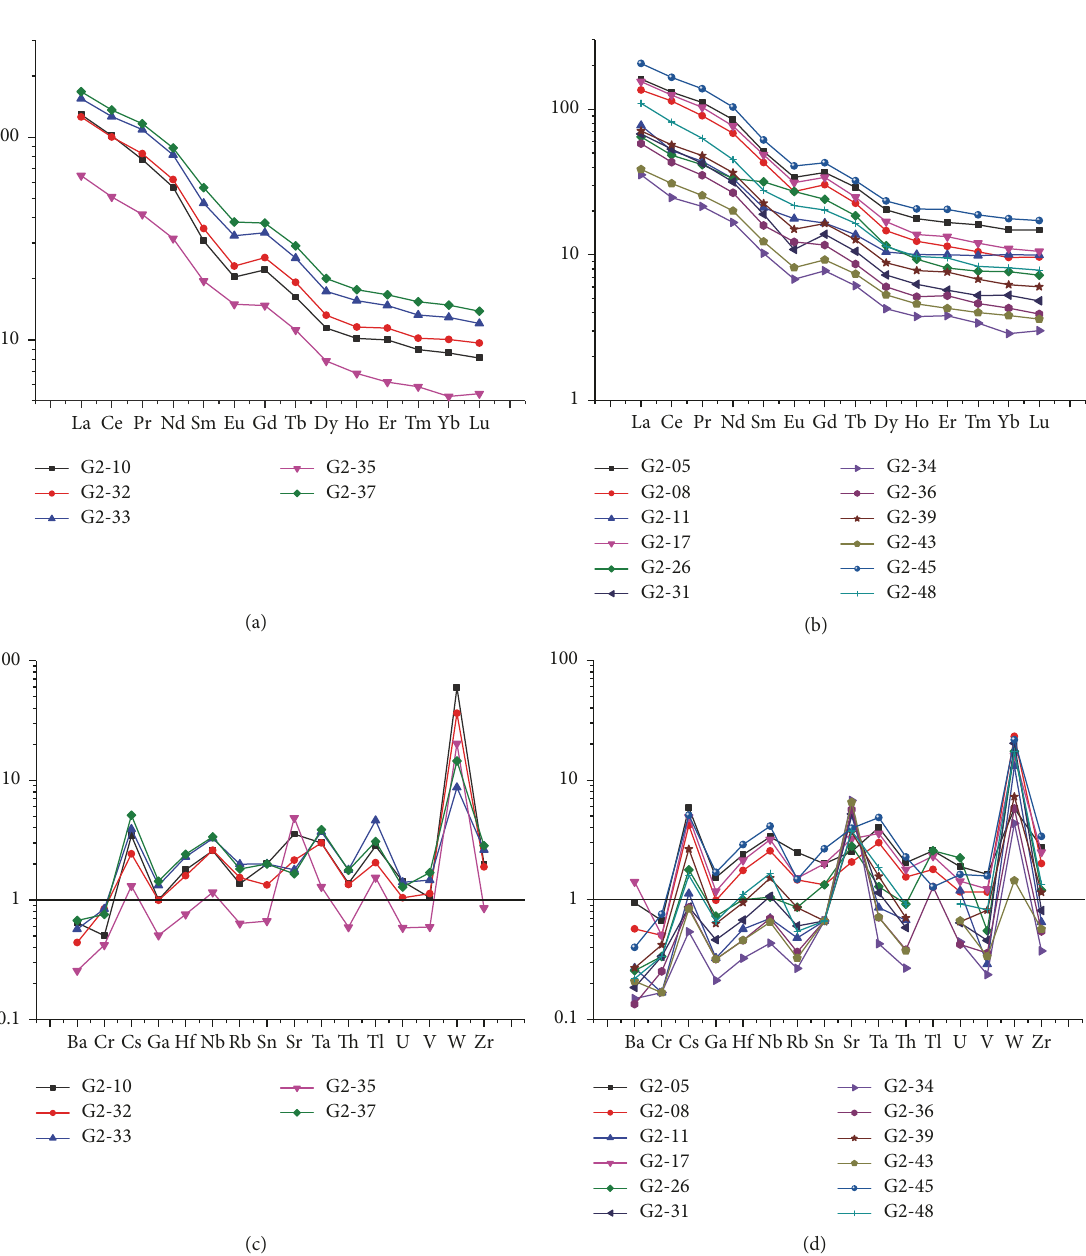
Figure 8: REE and trace element patterns or ore and wall rock in the Bojitian gold deposit . (a), (b) REE patterns of ore and wall-rock samples, respectively. (c), (d) Trace element patterns of ore and wall-rock samples,